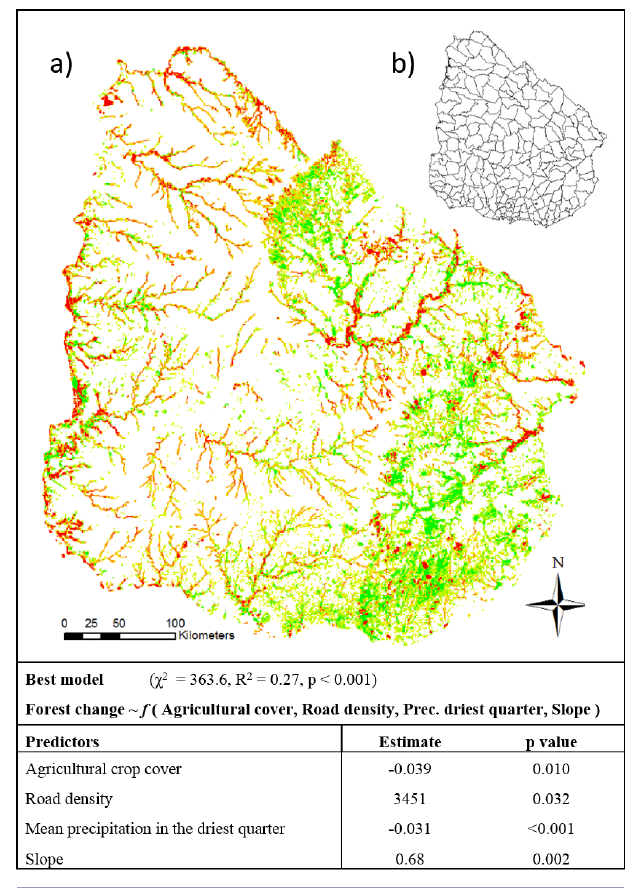
Fig. 1 . Forest cover change in Uruguay (1966-2011) and explanatory drivers. (a) Net forest loss in red and net forest gain in green in a 1-km² raster. Colored regions largely depict forest distribution in Uruguay. (b) Census divisions, used as analysis units. Bottom panels: Generalized linear model of forest cover change (%) between 1966 and 2011 for Uruguay.